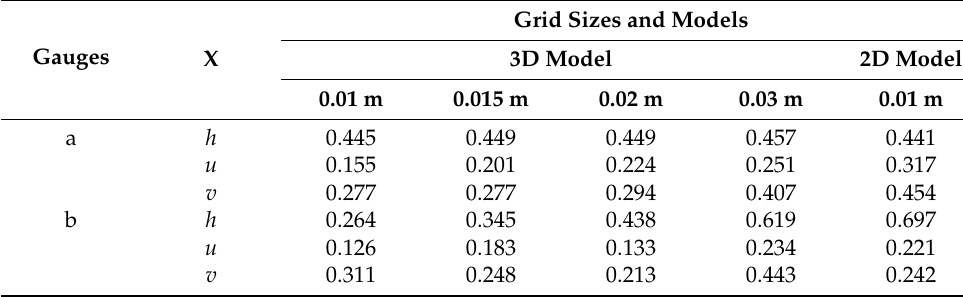
Table 1. The NRMSE value of various grid sizes and